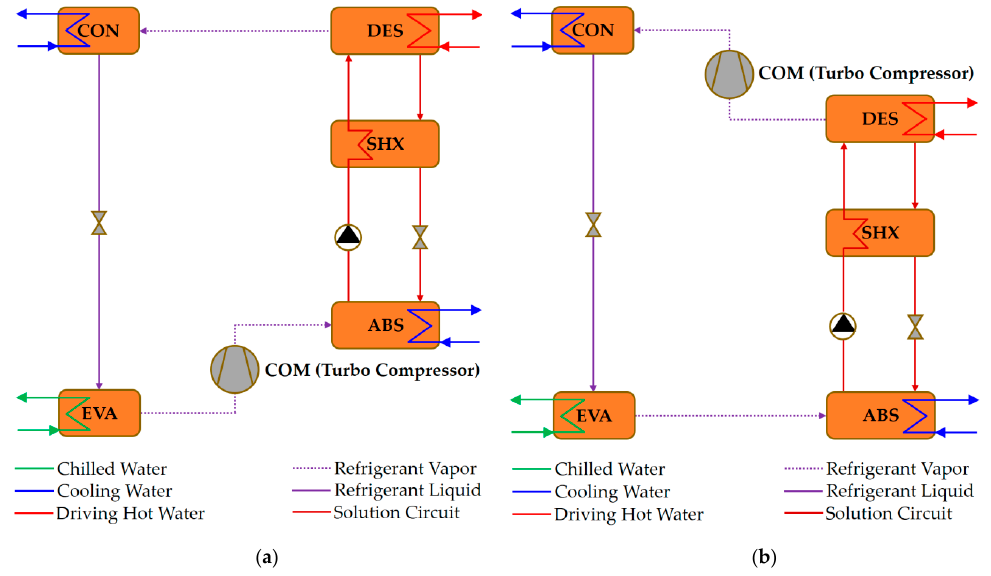
Figure 18. Single ‐ stage water/LiBr cycle with an integrated mechanical compressor between the ( a ) evaporator and absorber and the ( b ) desorber and condenser. Adapted from References [82,83]. Note: ABS=absorber; COM=compressor; CON=condenser; DES=desorber; EVA=evaporator; SHX=solution heat exchanger.